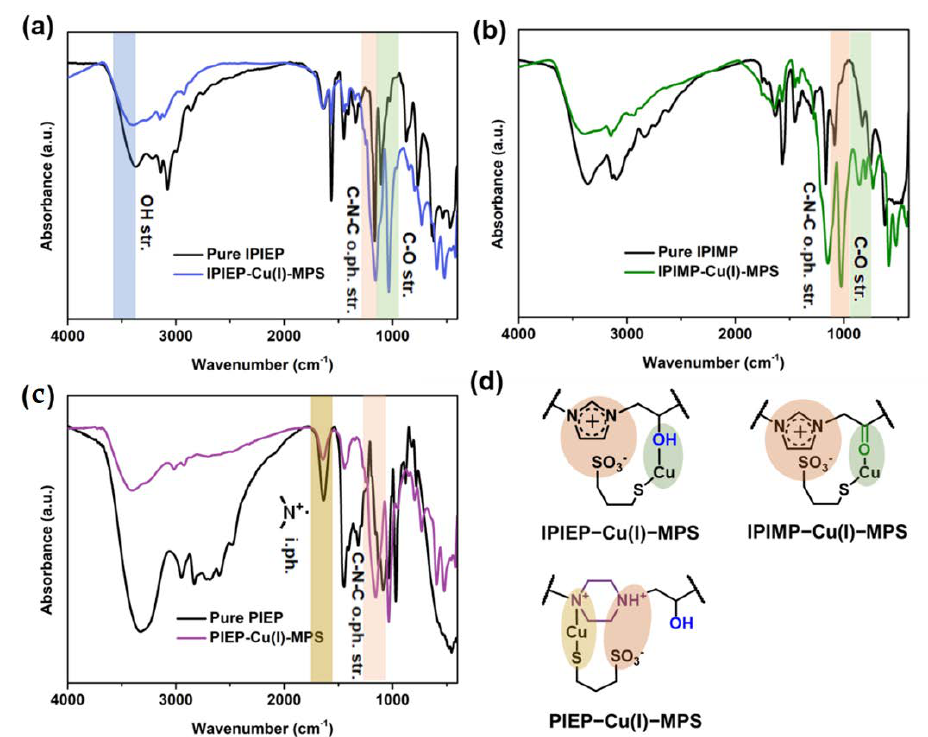
Figure 9. IR spectra of oligomer − Cu(I) − MPS: ( a ) PIEP, ( b ) IPIMP, and ( c ) IPIEP. ( d ) The schematic diagram of the oligomer − Cu(I) − MPS adducts.